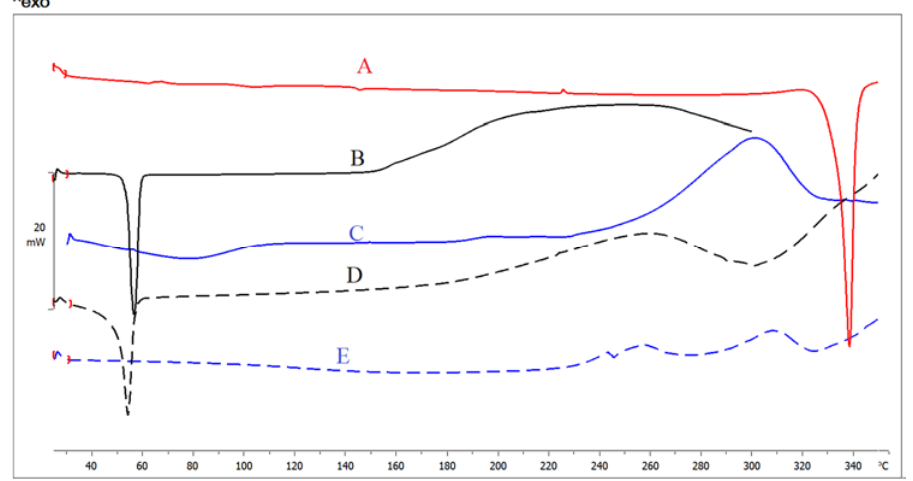
Figure 5. DSC thermograms of ( A ) LT, ( B ) Pluronic F127, ( C ) alginate, ( D ) NS2, and ( E ) NS12.